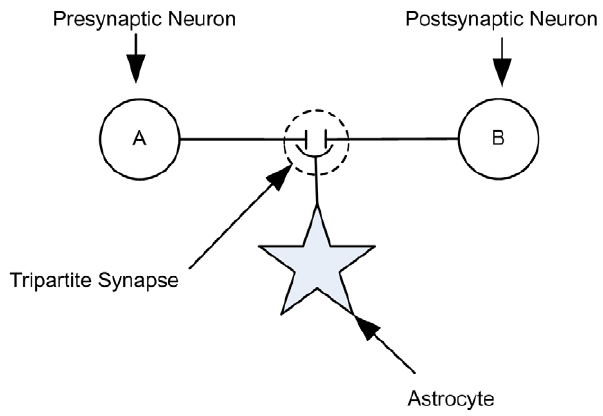
Figure 3. Network consists of presynaptic neuron A, postsyn- aptic neuron B and an interconnecting tripartite synapse. AN model is used for signaling between the tripartite synapse and astrocyte.